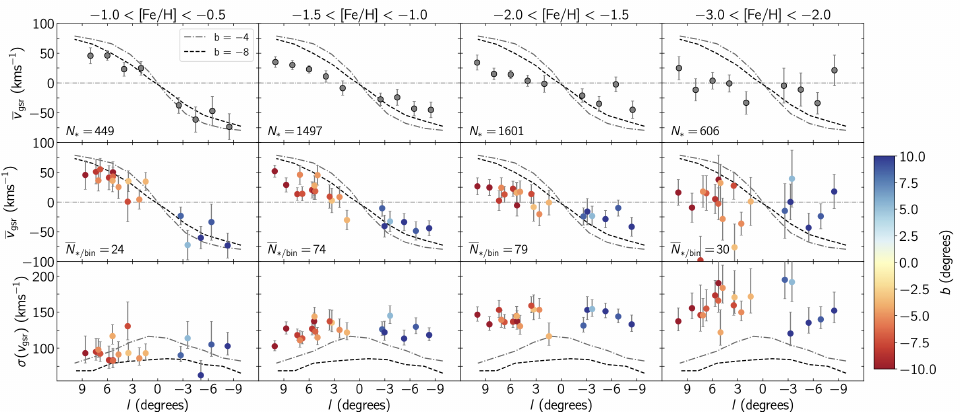
Figure 7. ( Top ) Galactic longitude versus mean Galactocentric velocity for different metallicity ranges. ( Middle row ) the same, but separately for each observed field with colors indicating the latitude of the field. ( Bottom row ) Galactic longitude versus standard deviation of the velocities, figure from Arentsen et al. (2020) [150]. Reproduced with permission from Arentsen, A., Monthly Notices of the Royal Astronomical Society Letters; published by Oxford University Press,